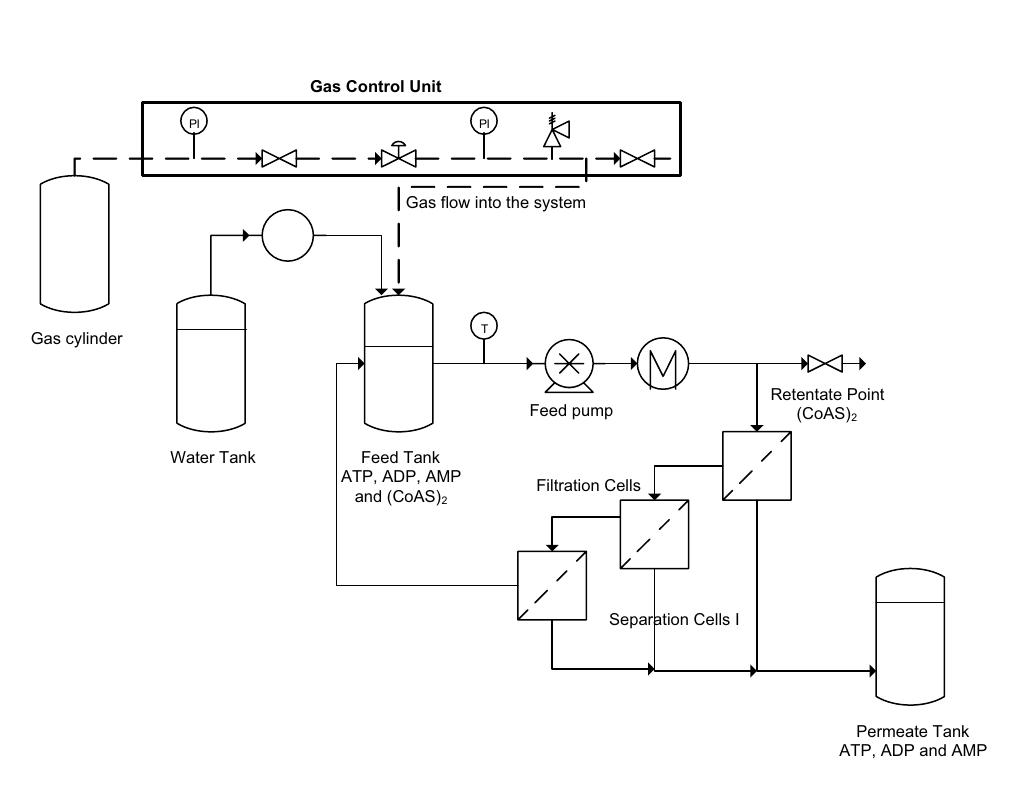
Figure 5. Experimental filtration set-up used for diafiltration